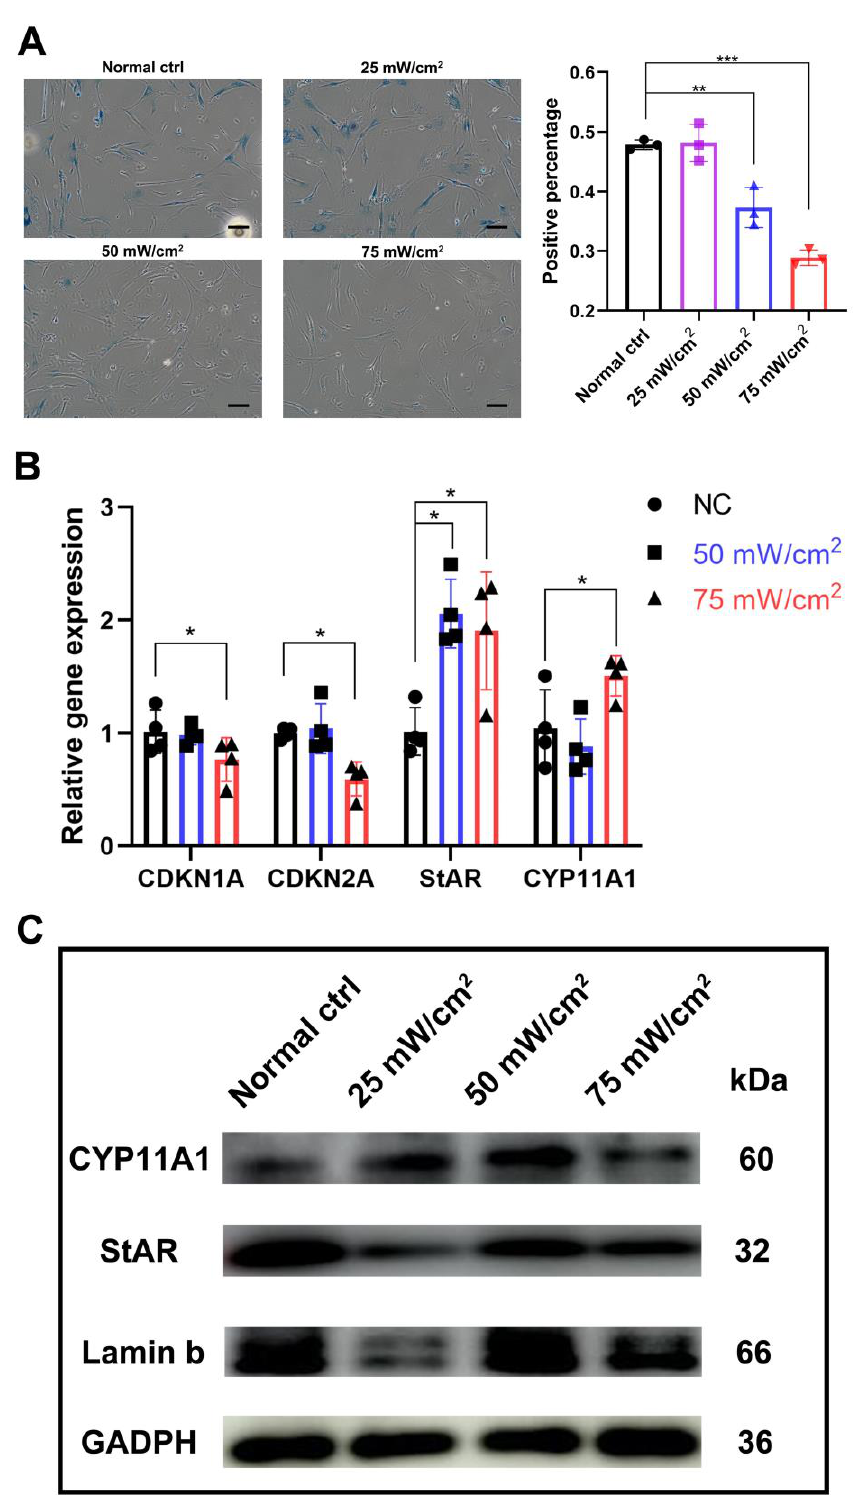
Figure 4. LIPUS delayed cellular senescence and testosterone-related enzyme synthesis pathways.